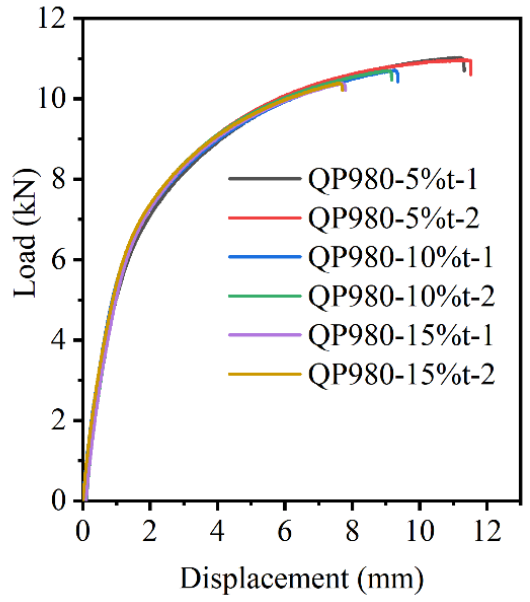
Figure 29. Load–displacement curves.